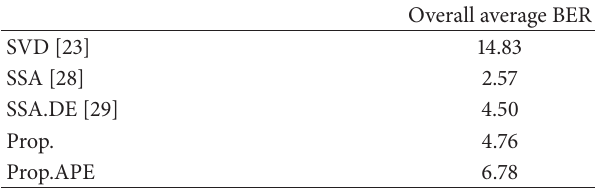
Table 6: Overall average BERs (%): comparison of the conventional SVD-based method (SVD), SSA-based scheme (SSA), SSA-based scheme with the differential evolution (SSA.DE), proposed scheme without the automatic parameter estimation (Prop.), and proposed one with the automatic parameter estimation (Prop.APE).